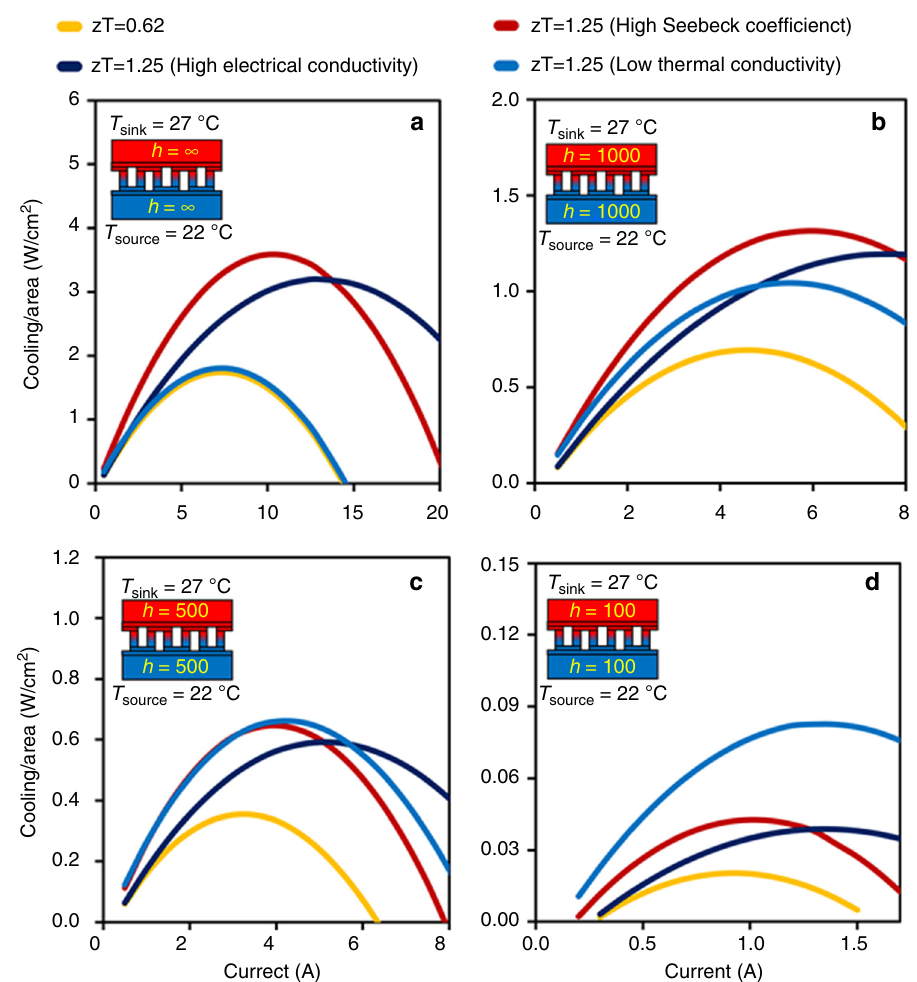
Fig. 2 The effect of thermally resistive environment on TE material behavior. Effect of material properties on cooling capacity changes with change in the environmental condition, even if zT value is the same. a , b When source/sink resistances are low ( h > 1000 W m − 2 K − 1 ), TE material with higher Seebeck coef fi cient is the best option. c , d When source and sink resistances are considerably high ( h = 100 − 500 W m − 2 K − 1 ), TE material with lower